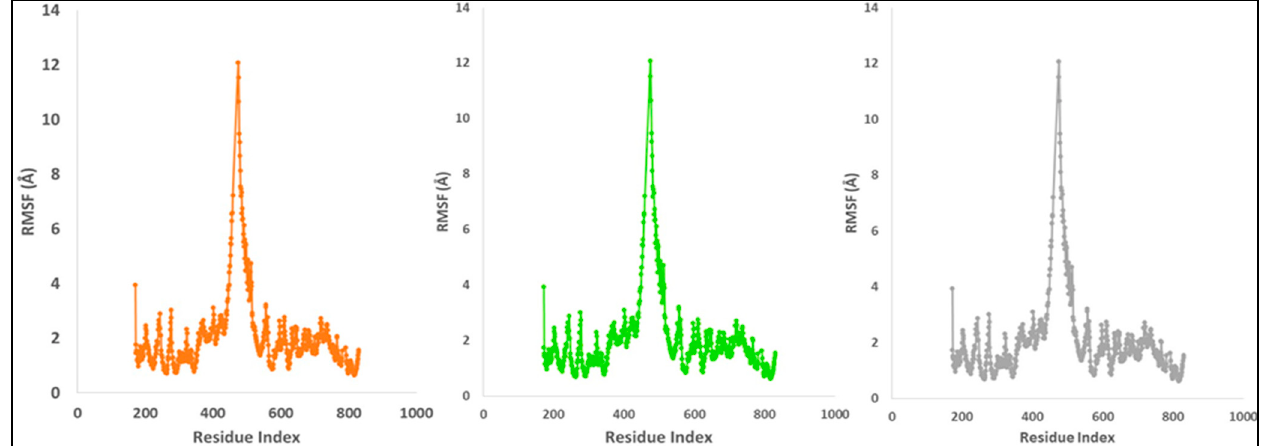
Figure 17. MD simulation trajectory analysis of Root Mean Square Fluctuations (RMSF) of com- pound 1 bound with LSD with their triplicate runs.